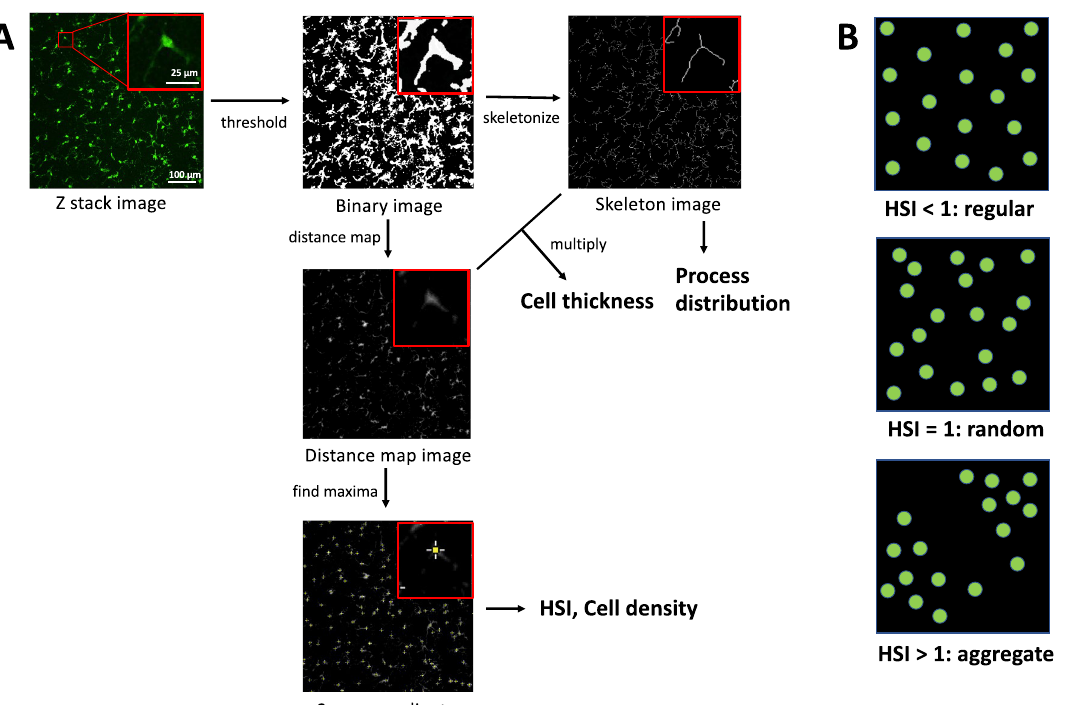
Figure 2. Image analysis. ( A ) Image processing for evaluation of microglia morphology (cell thickness and process distribution) and distribution (HSI and cell density). ( B ) Relationship between HSI and regularity of the microglia soma